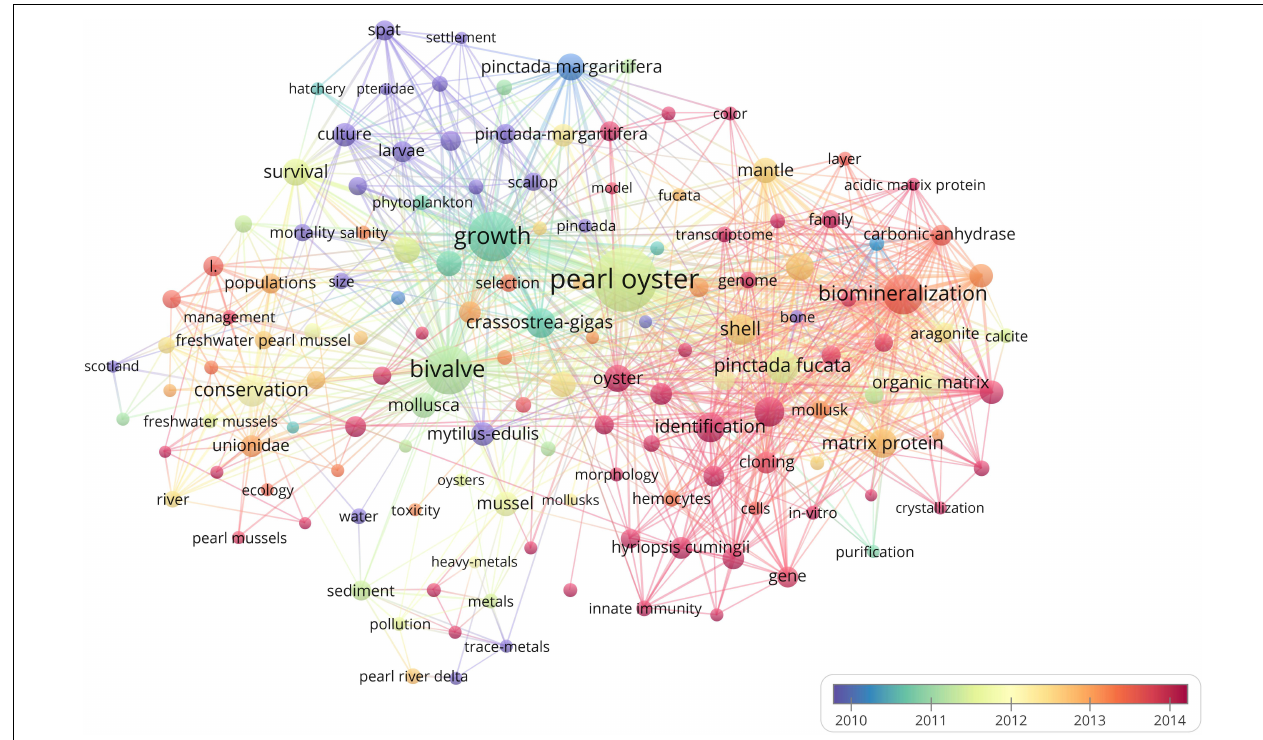
FIGURE 7 | Bibliometric map of the studies of pearl bivalve mollusks as the theme. The size of the dot is proportional to the frequency that a certain keyword appears in the analyzed articles. A line between two dots means that these two keywords appeared in the same article. The positive correlation between the thicker line and the higher frequency indicated that the two keywords appeared continually in the same articles. The color stands for the year when a certain keyword most frequently occurred in articles.